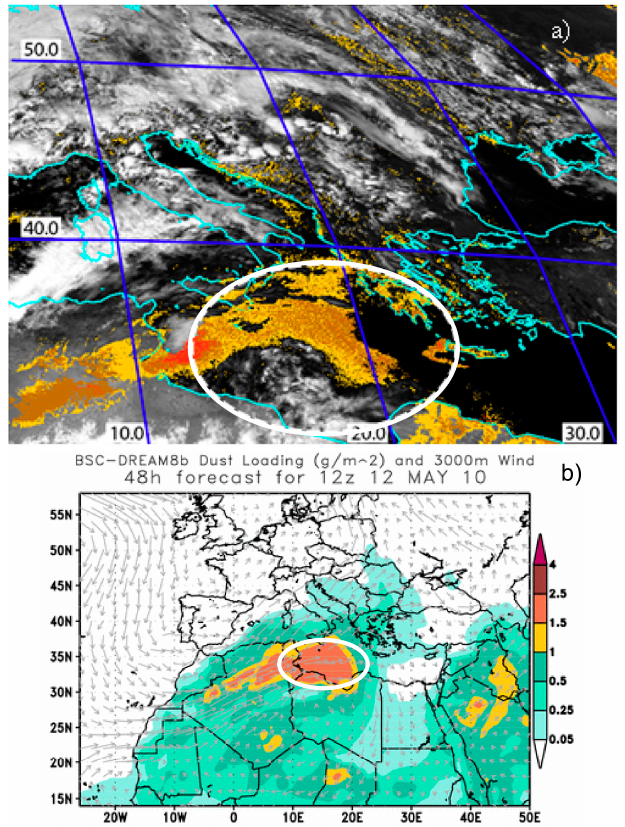
Figure 12. ( a ) Daytime e RST DUST product of 12 May 2010 at 12:00 UTC displaying dusty pixels characterized by different values of ⊗ Δ TIR ( x,y,t ) index; i.e., ⊗ Δ TIR ( x,y,t ) < 0 (orange pixels); < − 1 (brown pixels); < − 2 (red pixels); ( b ) BSC-DREAM forecast products for 12 May 2010 at 12:00 UTC. See the good spatial agreement characterizing the detected and predicted dust plume, apart for regions strongly affected by meteorological clouds (see region marked by white ellipse).